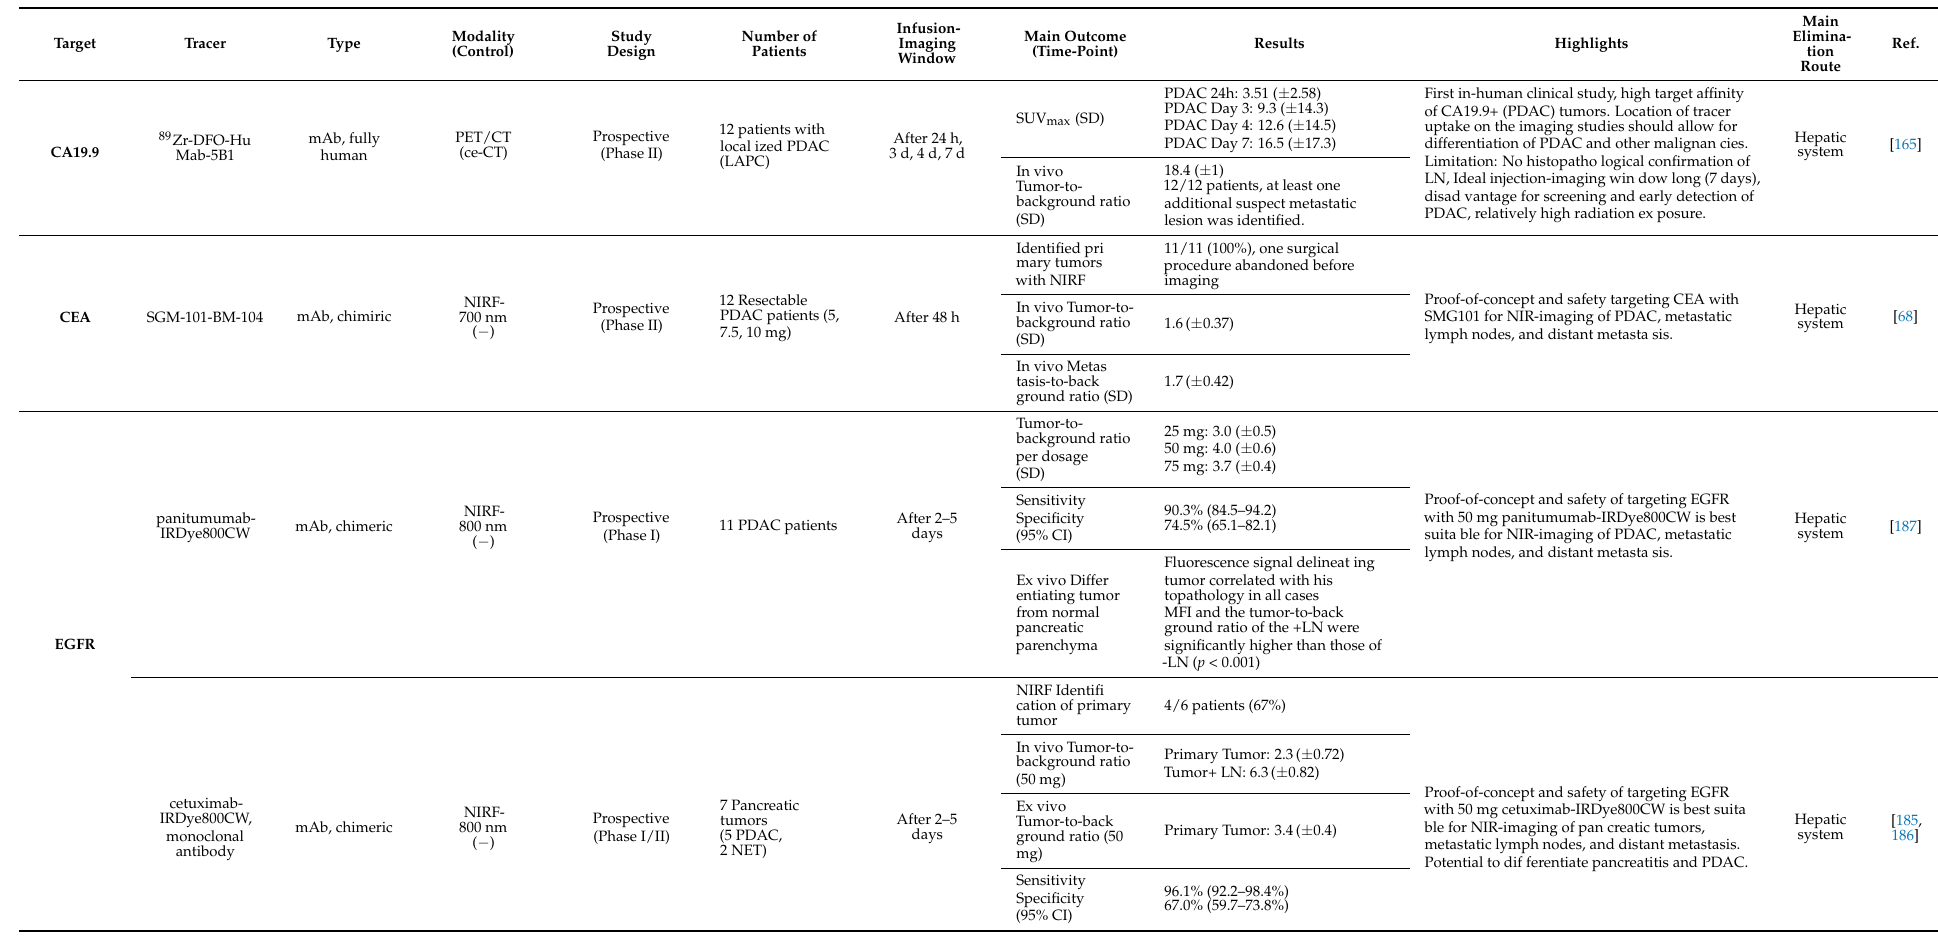
Table A1. Clinical studies evaluating targeted molecular imaging (PET/CT—fluorescence Imaging) of